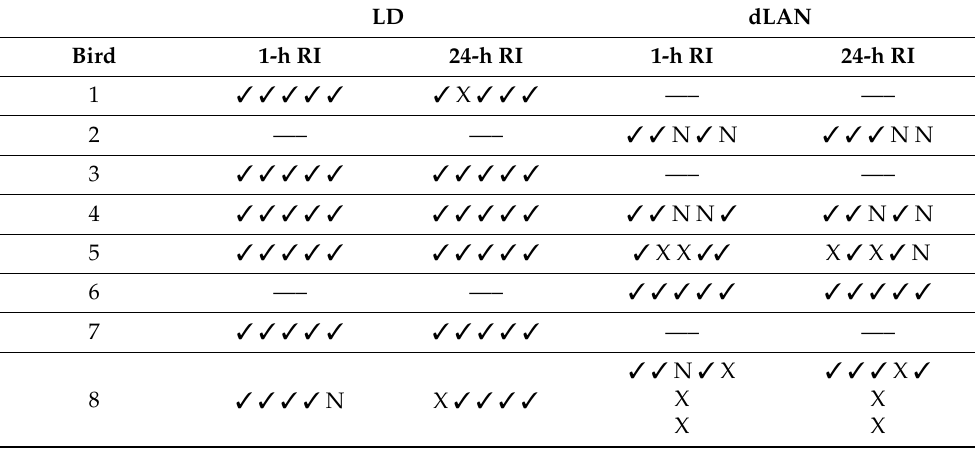
Table 2. The colour learning and memory task of male zebra finches ( Taeniopygia guttata ) under LD (12L:12D) and dLAN (12L:12dLAN) light condition as described in Figure 1. The table shows colour association memory performance after 1-h RI (retention interval) and 24-h RI (retention interval). In total, 5 trials of 10 min were given during memory retention. (cid:51) = correct response; X = no. of incorrect response in particular trial; N = not attempted in particular